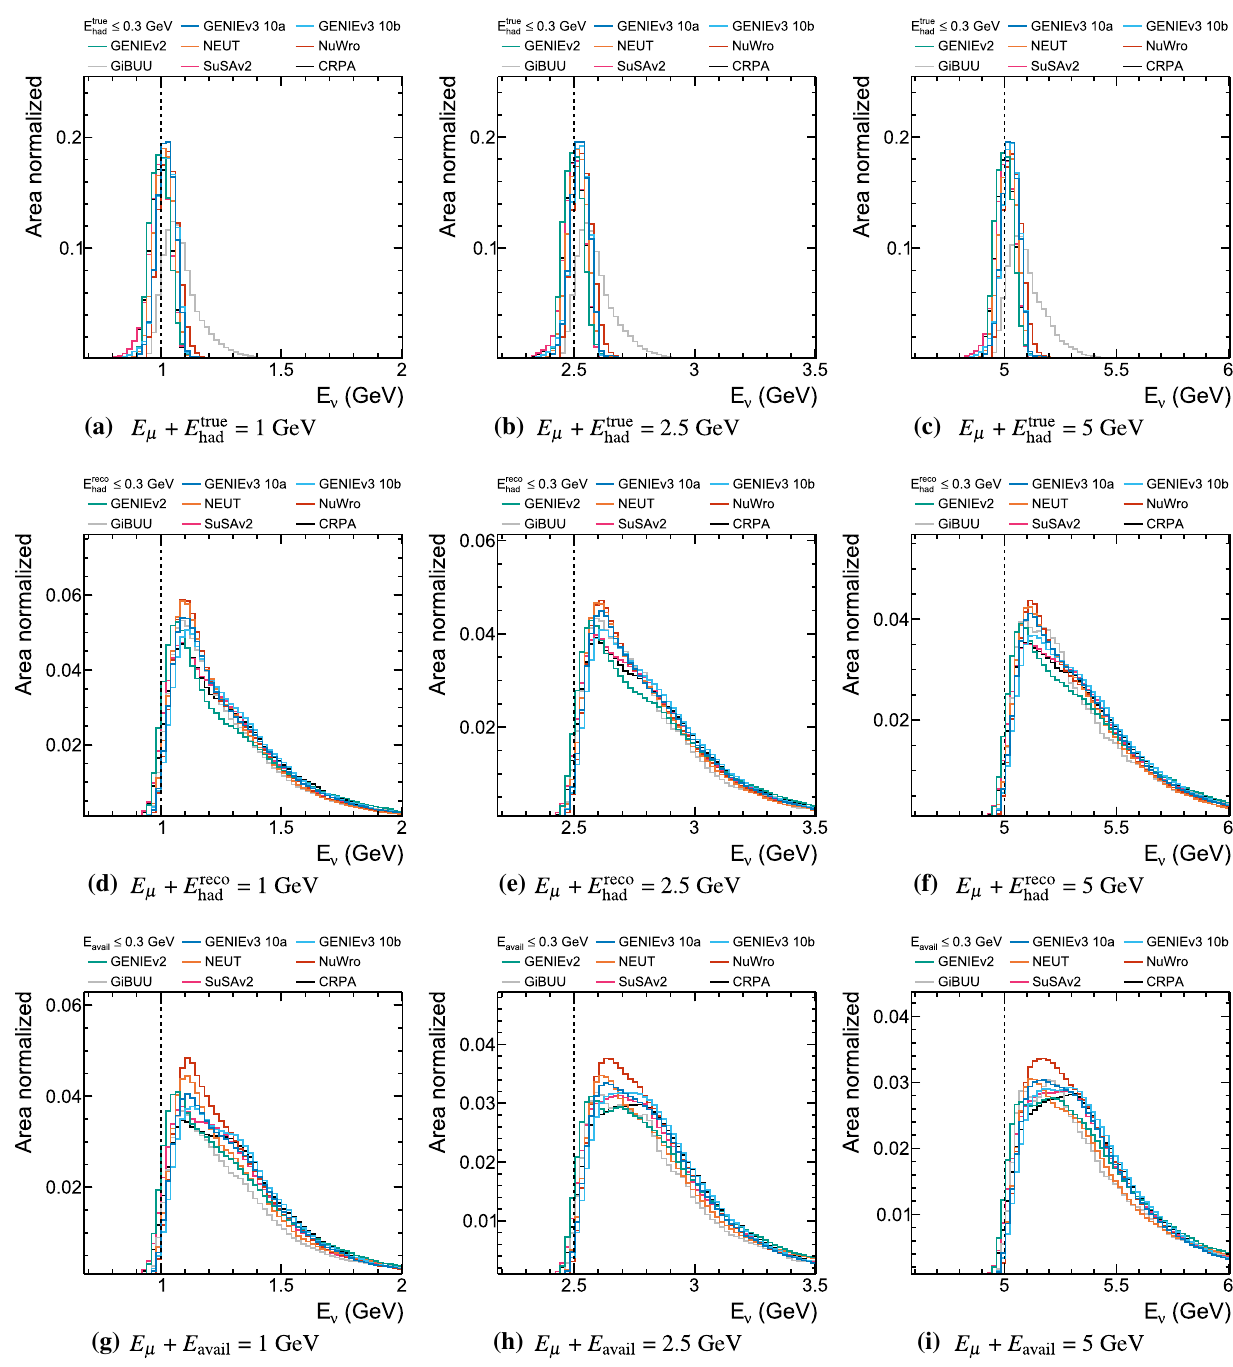
Fig. 11 Area normalized distributions of E true ν corresponding to fixed values of the three proxy E reco ν variables, E μ + E true E avail , at 1, 2.5 and 5 GeV, shown for ¯ ν μ – 40 Ar events, for all generator models of interest. A cut on the relevant q 0 proxy of ≤ 0.3 GeV is made in each